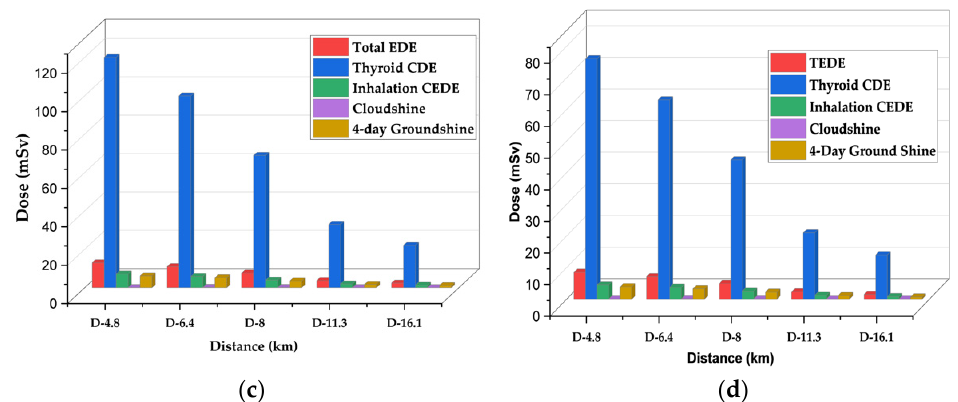
Figure 8. Graph of maximum TEDE, Inhalation CEDE, Thyroid, Cloudshine, and 4-day ground shine during long-term station blackout. ( a ) represents maximum doses within a 16 km radius from the APR1400 reactor. ( b ) represents maximum doses with a 16 km radius from the VVERR reactor. ( c ) represents maximum doses with a 16 km radius from the HPR1000 reactor. ( d ) represents maximum doses within a 16 km radius from the Nuscale Power Module.